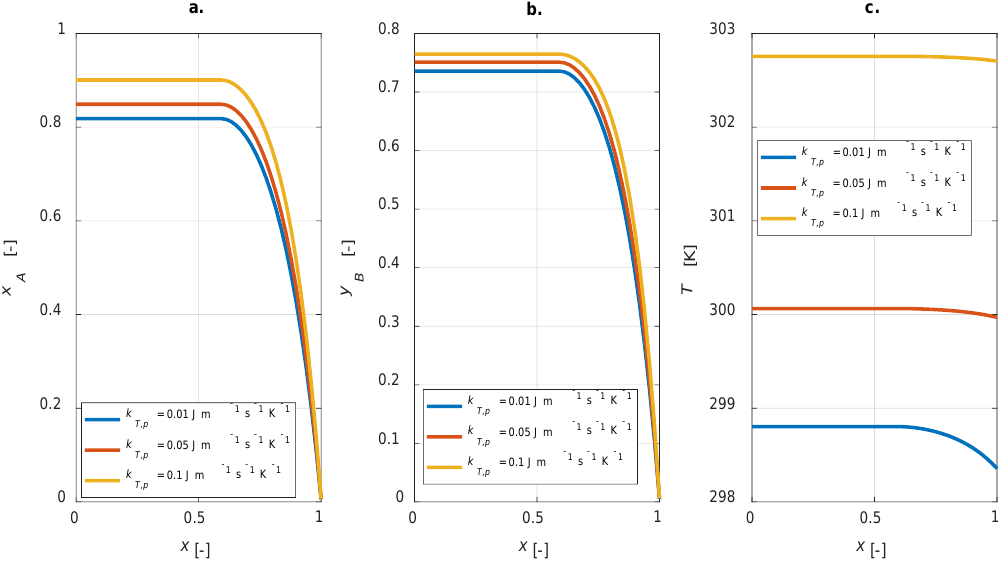
Figure 7. Intraparticle profiles: k T,p sensitivity study. ( a ) A conversion; ( b ) yield to B; ( c )